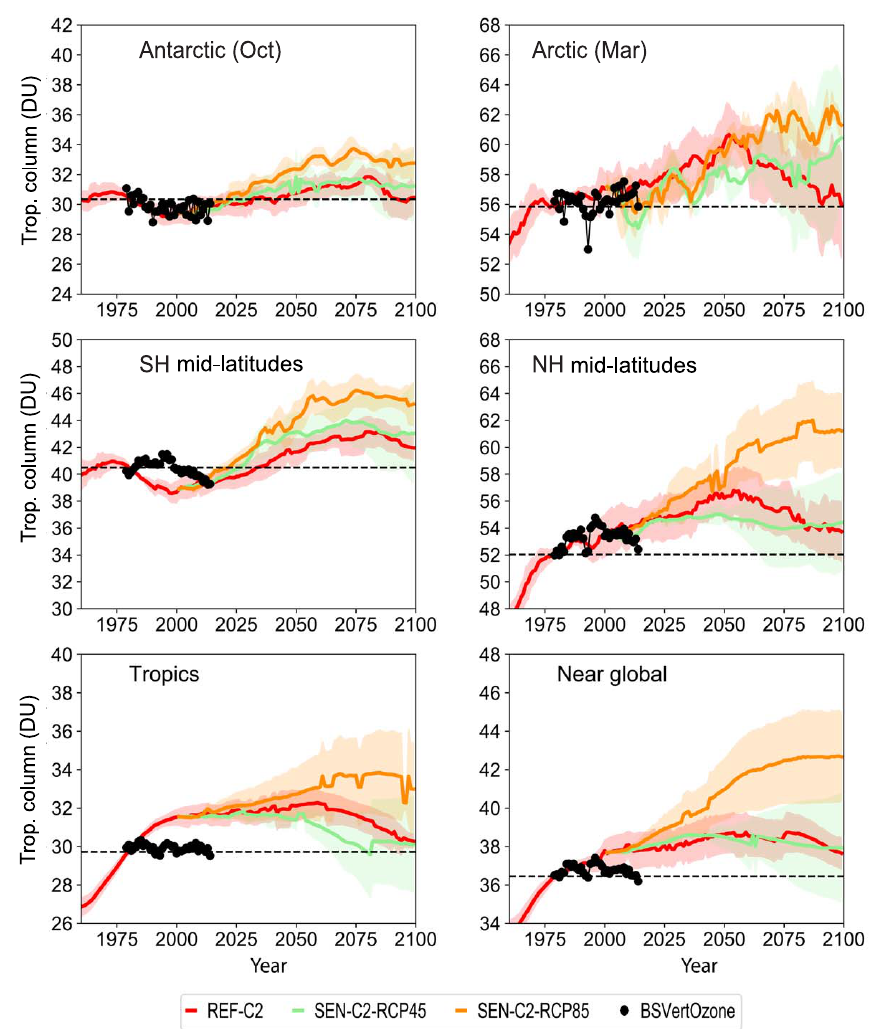
Figure 10. Evolution of tropospheric partial column ozone (DU) (surface–tropopause) MMM1S for REF-C2 and the RCP scenarios SEN- C2-RCP45 and SEN-C2-RCP85. Also shown is the tropospheric partial column ozone derived from BSVertOzone